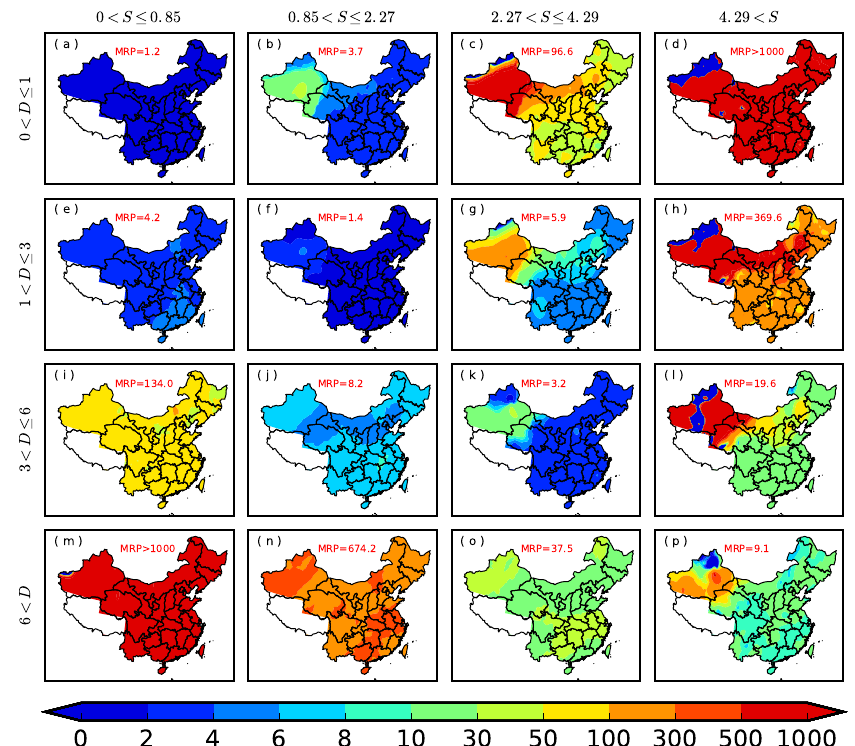
Figure 13. Return period based on conventional method (the unit of the colored bar is years). ( a – p ) represent the different drought types.